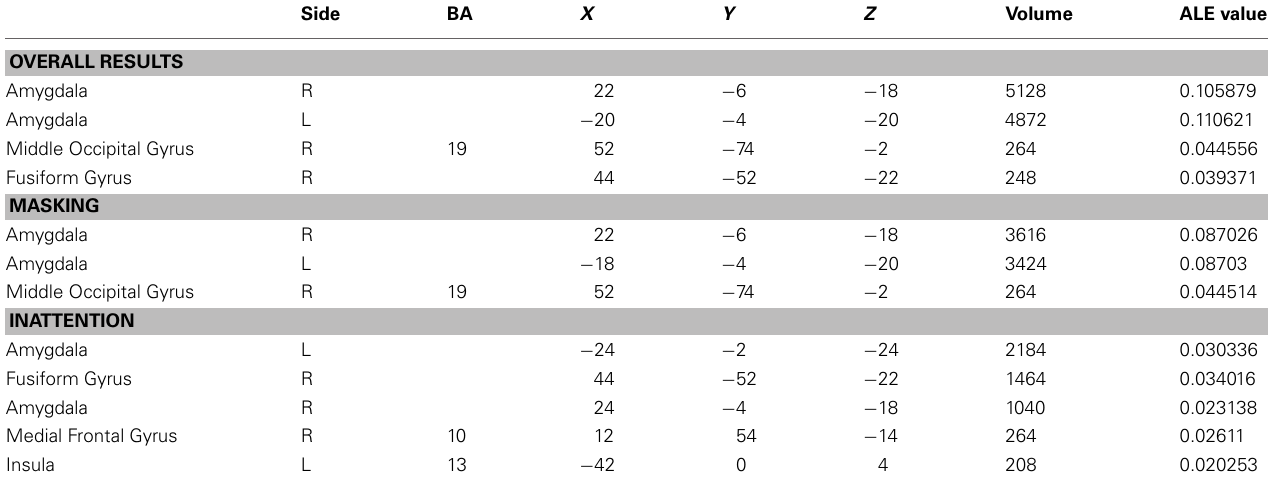
Table 2 | ALE values of implicit processing of emotional faces.